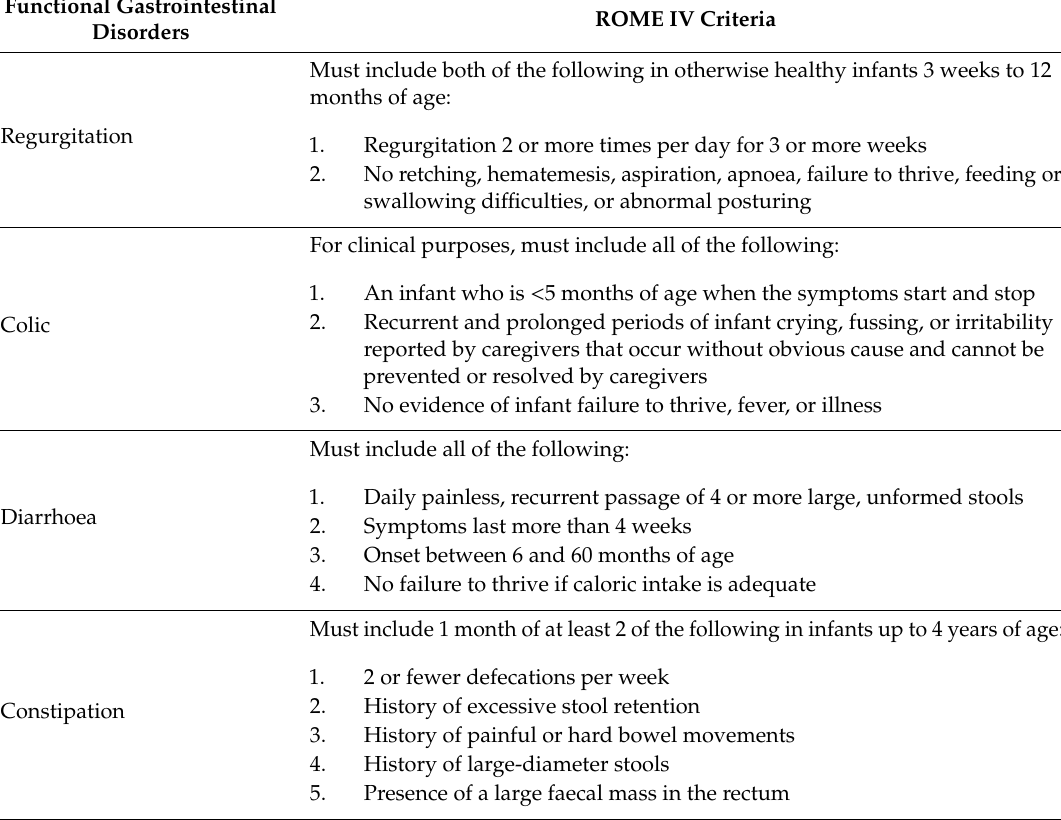
Table 1. Diagnosis criteria for functional gastrointestinal disorders in infants—ROME IV criteria. Functional